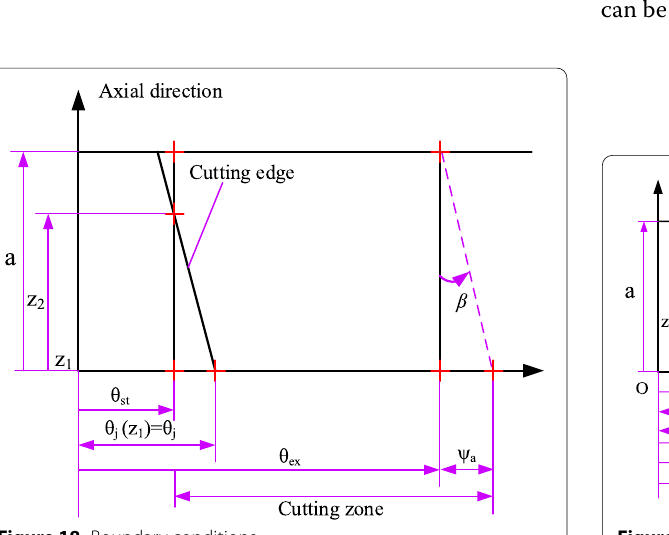
Figure 18 Boundary conditions Figure 19 Integral